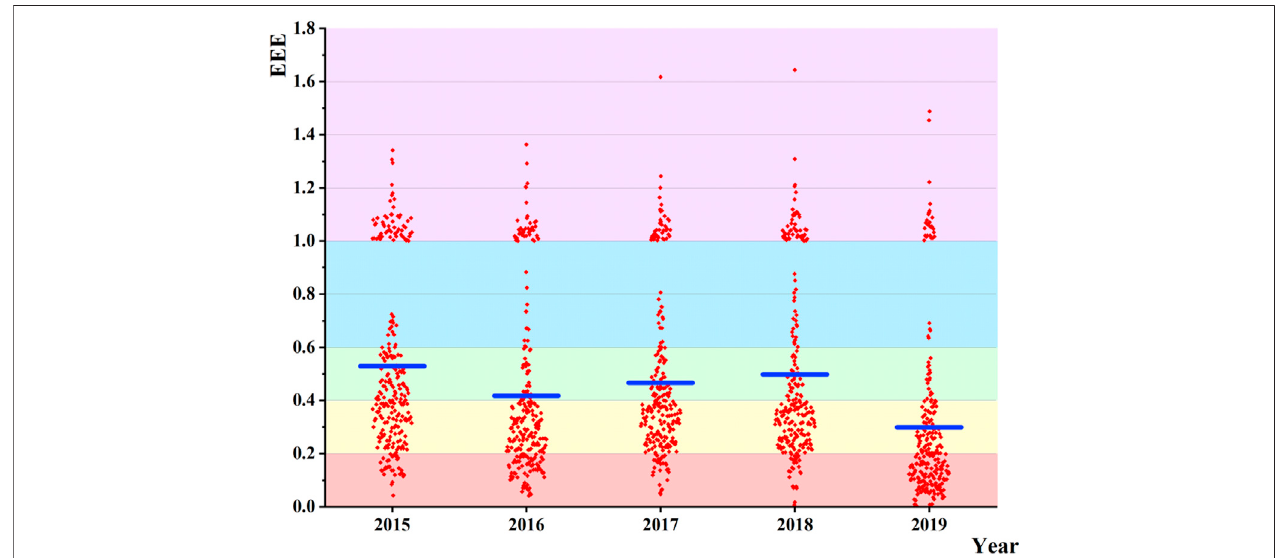
FIGURE 4 | Scatter plot on the EEE values between 255 Chinese cities from 2015 to